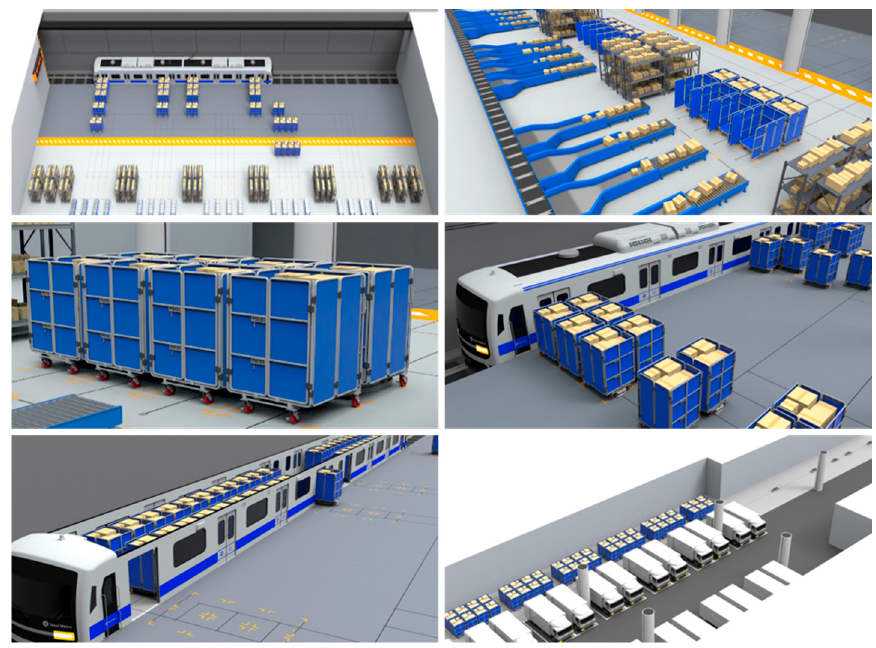
Figure 1. Concept of underground logistics system.